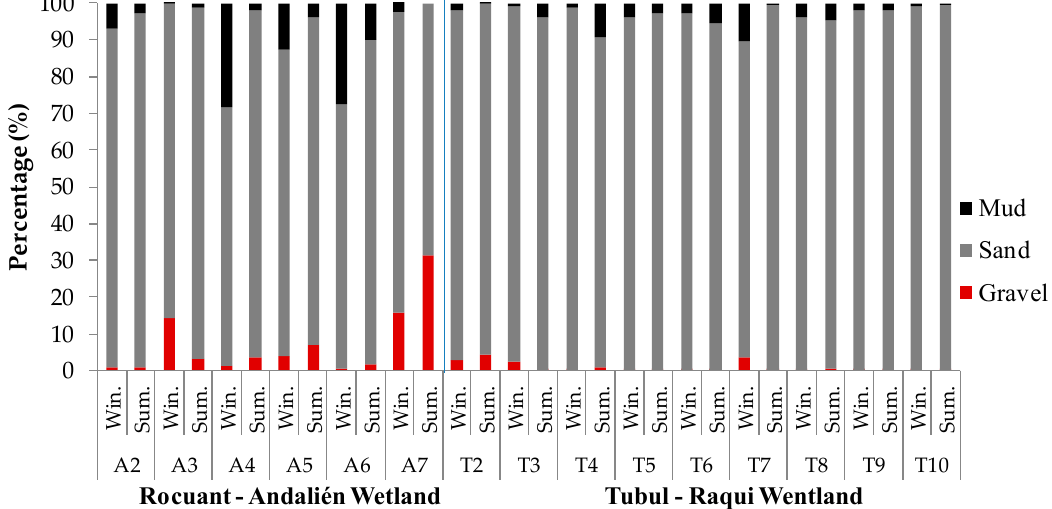
Figure 4. Granulometric analysis of the Rocuant-Andalién and Tubul-Raqui stations during summer and winter .